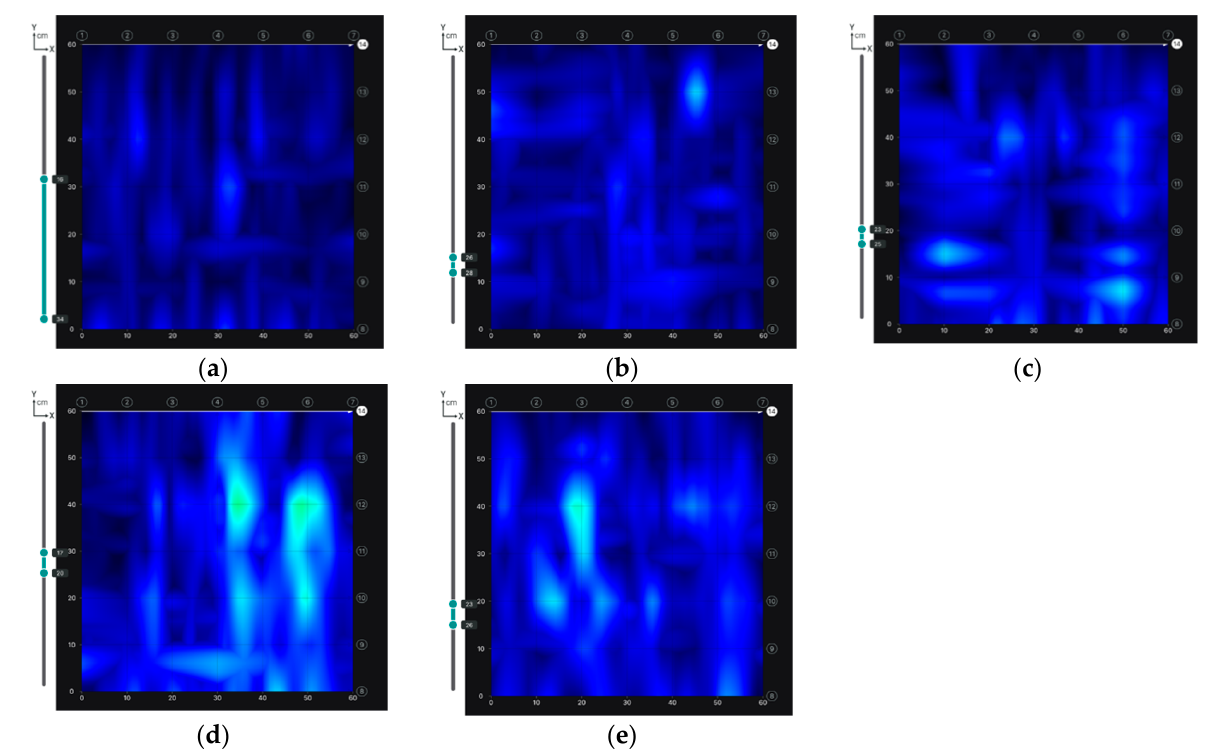
Figure 10. Testing of the location of internal defects in concrete using the radar method in measuring points: ( a ) P1, ( b ) P2, ( c ) P3, ( d ) P4, ( e ) P5.